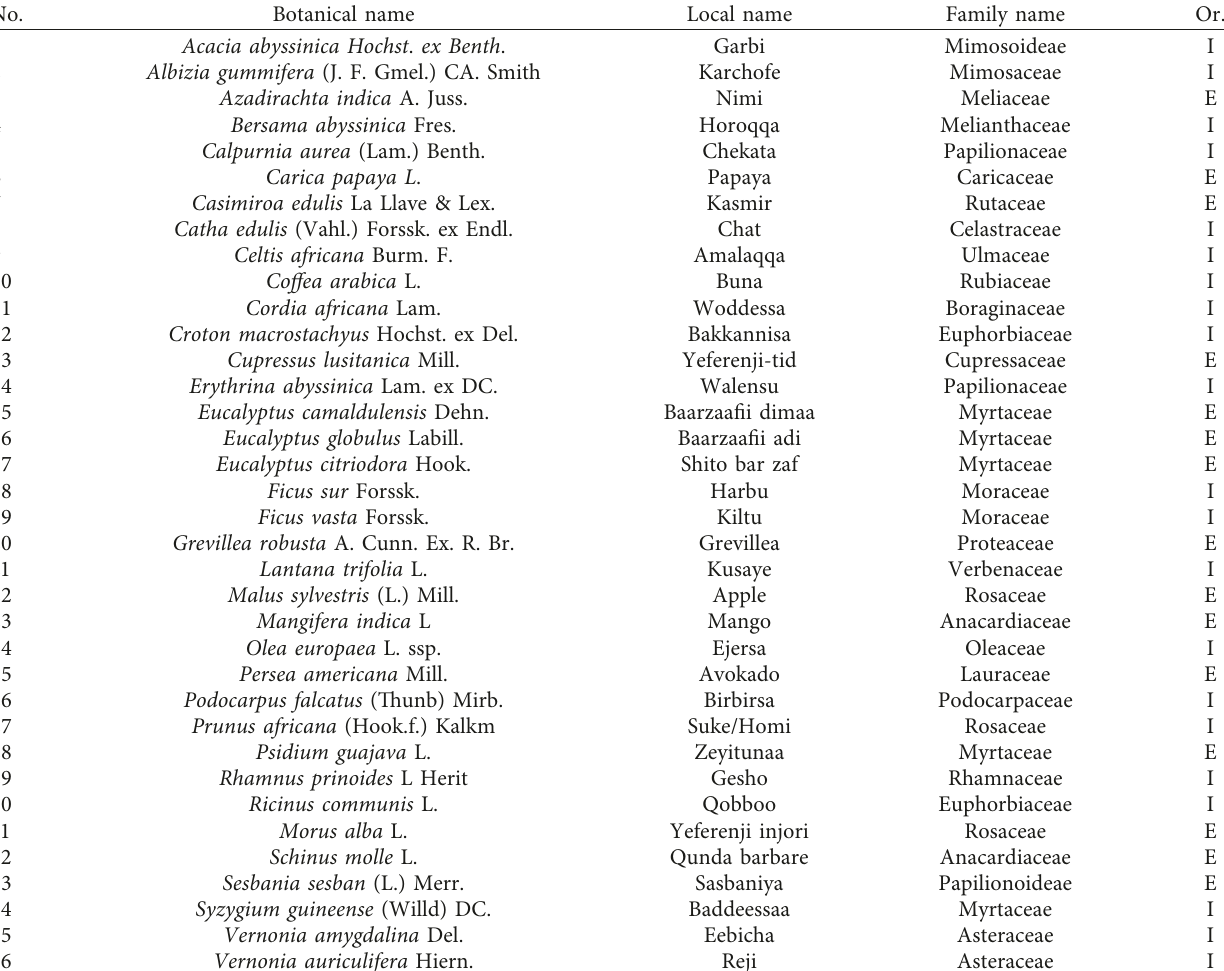
Table 1: Local, botanical, family names, and origin of woody species of the study site.